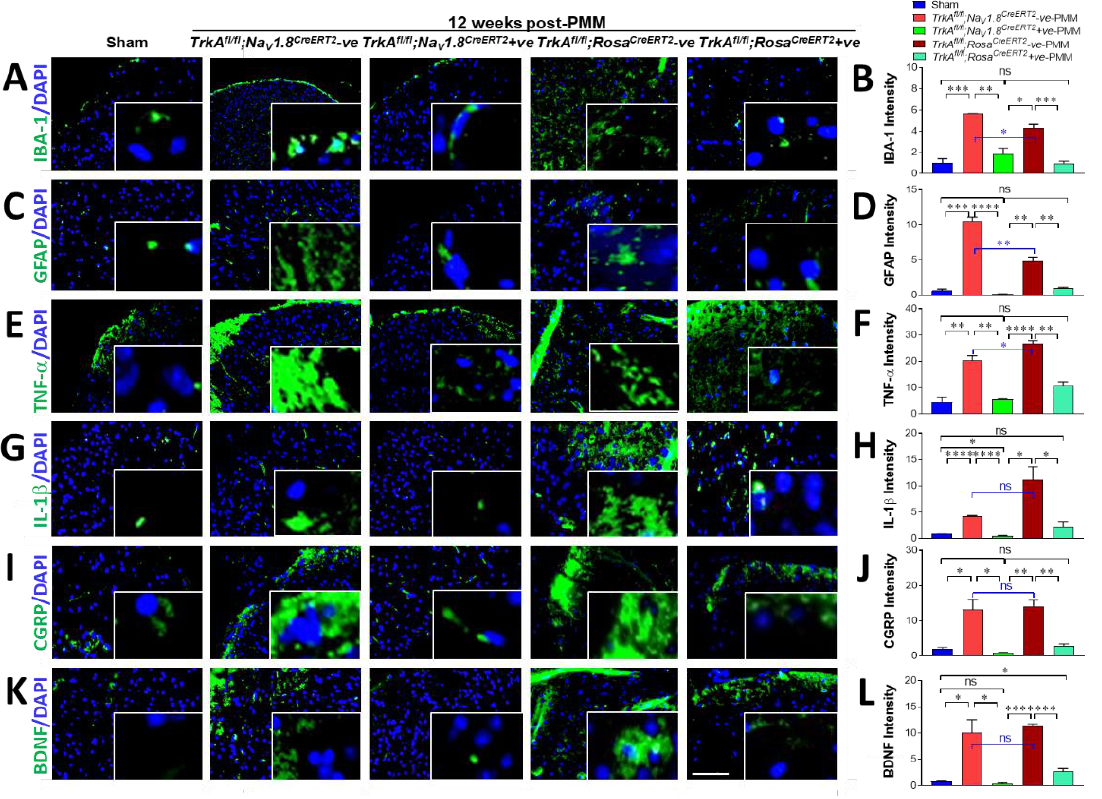
Figure 8. Sensory-neuron-specific deletion of TrkA in mice ( TrkA fl/fl ;Na V 1.8 CreERT2 -positive) reduced glial cell activity and pain molecule CGRP and BDNF significantly in spinal cords. ( A ) Representa- tive immunofluorescence images of staining for IBA-1 (green) in SC of TrkA fl/fl ;Na V 1.8 CreERT2 -negative ( n = 9), TrkA fl/fl ;Na V 1.8 CreERT2 -positive ( n = 12), TrkA fl/fl ;Rosa CreERT2 -negative ( n = 11), and TrkA fl/fl ;Rosa CreERT2 -positive ( n = 5) mice. ( B ) Quantitative analyses of IBA-1. Following PMM surgery, 4 (cid:48) ,6-diamidino-2-phenylindole (DAPI) stained nuclei blue. ( C , D ) Astroglial marker GFAP expression (green; ( C )) and quantification of GFAP ( D ) in the SC of TrkA -deleted mice after PMM compared to TrkA fl/fl ;Na V 1.8 CreERT2 -negative ( n = 9), TrkA fl/fl ;Na V 1.8 CreERT2 -positive ( n = 12), TrkA fl/fl ;Rosa CreERT2 -negative ( n = 11), and TrkA fl/fl ;Rosa CreERT2 -positive ( n = 5) mice. 4 (cid:48) ,6-Diamidino-2-phenylindole (DAPI) stained nuclei blue. Not significant compared between sham control and TrkA fl/fl ;Na V 1.8 CreERT2 +ve mice and TrkA fl/fl ;Rosa CreERT2 -positive with PMM. Representative immunofluorescence images of tumor necrosis factor- α (TNF- α ) expression and quantitative analyses ( E , F ), interleukin (IL)-1 β ex- pression and quantitative analyses ( G , H ), CGRP expression and quantitative analyses ( I , J ), and BDNF expression and quantitative analyses ( K , L ) in SC of sham control, TrkA fl/fl ;Na V 1.8 CreERT2 - negative, TrkA fl/fl ;Na V 1.8 CreERT2 +ve, TrkA fl/fl ;Rosa CreERT2 -negative, and TrkA fl/fl ;Rosa CreERT2 -positive mice are shown. Values are mean ± SEM. 4 (cid:48) ,6-Diamidino-2-phenylindole (DAPI) stained nuclei blue. * p < 0.05, ** p < 0.01 *** p < 0.001, **** p < 0.0001, ns: not significant. p = 0.962 (IBA- 1 sham vs. TrkA fl/fl ;Rosa CreERT2 -positive PMM), p = 0.062 (TNF- α sham vs. TrkA fl/fl ;Rosa CreERT2 - negative PMM), p = 0.234 (IL-1 β sham vs. TrkA fl/fl ;Rosa CreERT2 -positive PMM), p = 0.051 (IL-1 β TrkA fl/fl ;Na V 1.8 CreERT2 -negative PMM vs. TrkA fl/fl ;Rosa CreERT2 -negative PMM), p = 0.434 (CGRP sham vs. TrkA fl/fl ;Rosa CreERT2 -positive PMM), p = 0.809 (CGRP TrkA fl/fl ;Na V 1.8 CreERT2 -negative PMM vs. TrkA fl/fl ;Rosa CreERT2 -negative PMM), p = 0.123 (BDNF sham vs. TrkA fl/fl Na V 1.8 CreERT2 -positive PMM), p = 0.663 (BDNF TrkA fl/fl ;Na V 1.8 CreERT2 vs. TrkA fl/fl Rosa CreERT2 -negative PMM). Scale bar: 50 µ m. The astroglial cell marker GFAP in OA-induced TrkA fl/fl ;Na V 1.8 CreERT2 -negative mice was increased 16-fold and in TrkA fl/fl ;Rosa CreERT2 -positive OA mice in spinal cords compared